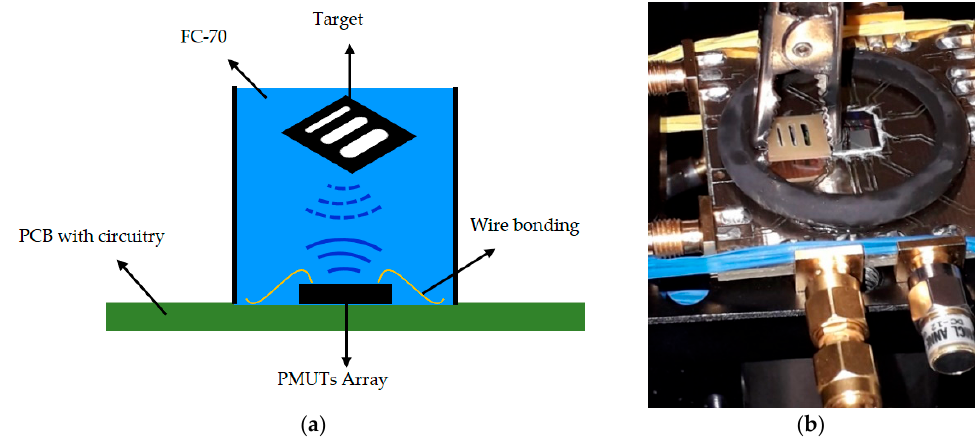
14 of 19 Figure 16. Dynamic range measurements: the VA amplifier (black) and the CSA amplifier (red). 4. Acoustic Characterization To validate the analog front-end CMOS in its intended application, an acoustic characterization was done using fluorinert (FC-70, where the mass density is ρ = 1940 kg m − 3 and the sound velocity is c = 690 m/s) as a propagation medium. The set-up is shown in Figure 17, where a grating phantom was introduced in a small pool, confining the FC-70 to approximately 2.1 mm over the 6 × 6 PMUT array surface. One row of this array was excited by the designed HV transmitter (four cycles at 3 MHz